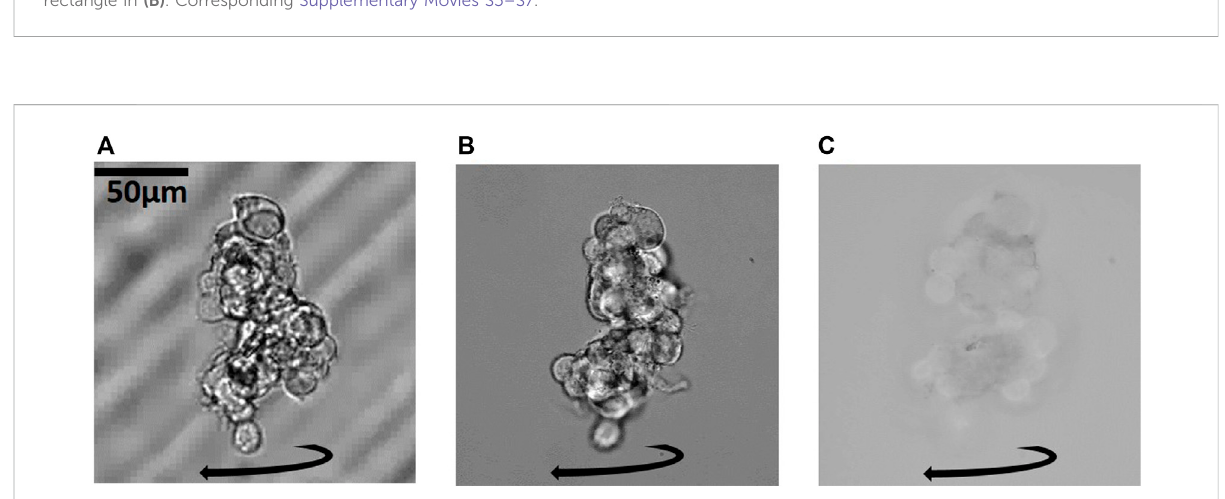
FIGURE 7 Optical sectioning, resolution and contrast of a cancer cell spheroid under sustained rotation: Increasing the imaging NA, from (A) NA obj = 0.25to (B) NA obj +NA con =1.3to (C) NA obj +NA con =2.3increasestheopticalsectioningandtheresolutionoftheobject.In (A) thecoverslipisvisible in the background. In (B) the optical sectioning and resolution is better. In (C) the optical sectioning is best and each image of the rotating spheroid shows a slice through the object at the highest resolution. For large objects, only the periphery is in focus, and there is a trade-off between highest resolution and sectioning in (C) compared to higher contrast and lower sectioning and resolution in (B) for inspection of a sample. Corresponding Supplementary Movies S8 –